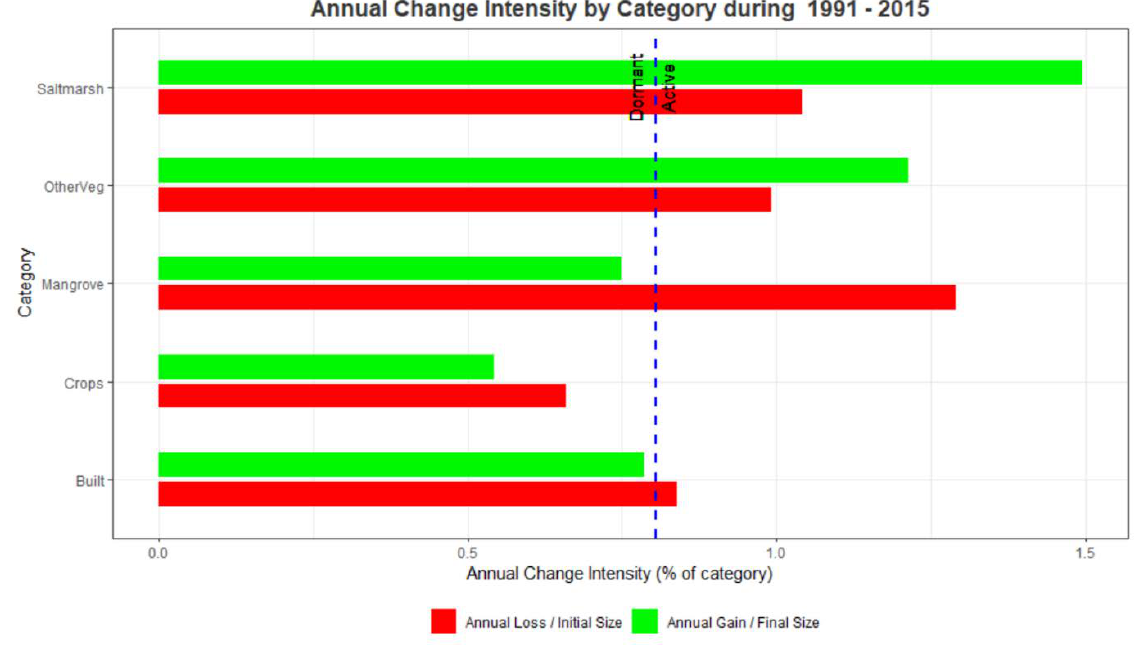
Figure 5. Annual change intensity in terms of gains (in green, calculated as the size of each gross annual gain divided by the size of the category at the final time point of the interval) and losses (in red; calculated as the size of each gross annual loss divided by the size of the category at the initial time point of the interval). The dashed vertical line indicates the land categories that are relatively dormant (left of the line) versus active (right of the line) in terms of loss and gain between 1991 and 2015, by comparing these intensities with uniform change in the study area. For more information see Pontius and Khallaghi